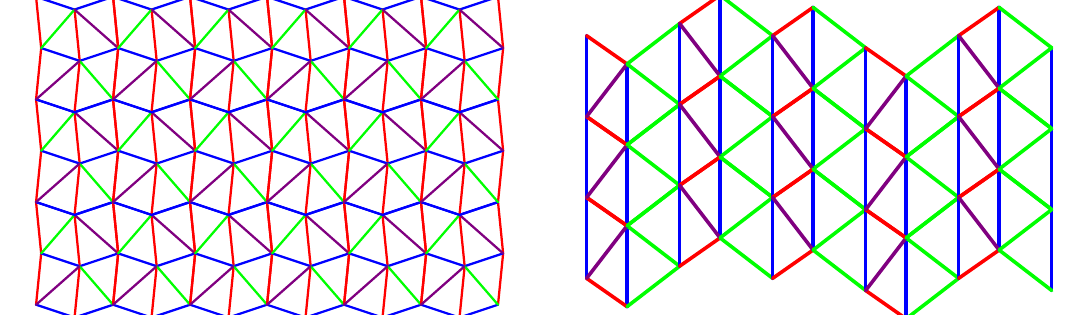
Fig. 16: Tiling with two different types of non- isosceles triangles.